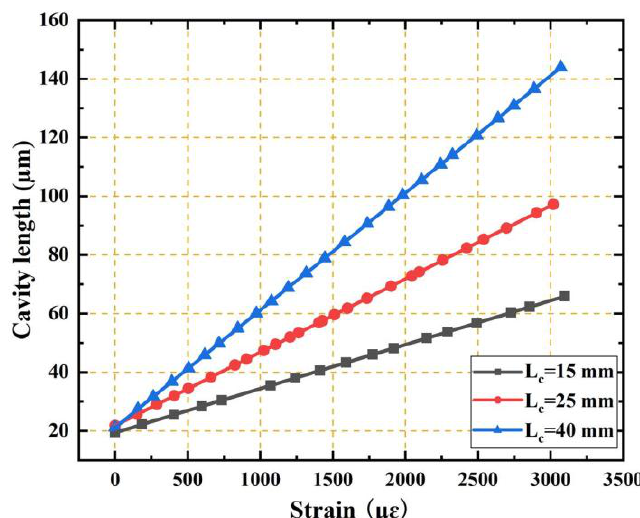
Figure 7. Relationships between the cavity length and the strain for three EFPI microcavity fiber-optic strain sensors with the same initial cavity length of 20 µ m, but di ff erent capillary lengths (15 mm, 25 mm, and 40 mm). The cavity length–strain sensitivities of the three sensors were 15.928 nm / µε , 25.281 nm / µε , and 40.178 nm / µε , respectively. Evidently, the sensitivity is directly proportional to the capillary length, and can be greatly enhanced by the capillary length.